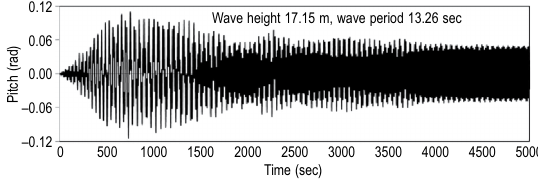
Fig. 9. Maximum tension in mooring line